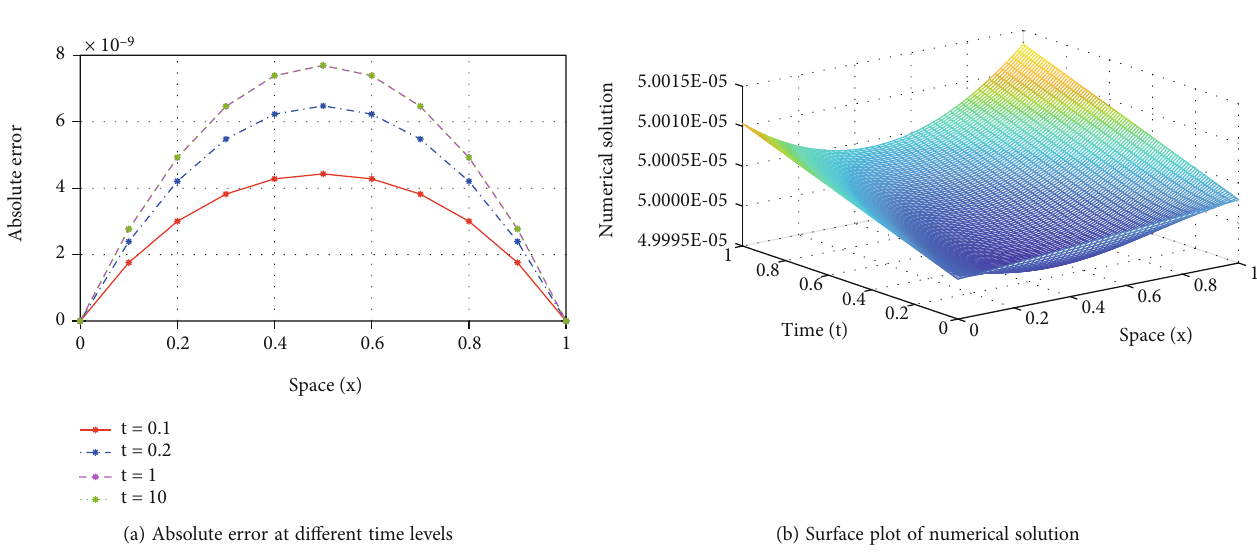
Figure 8: Error and solution pro fi le of Example 6 with N = 50 and Δ t = 0 : 01